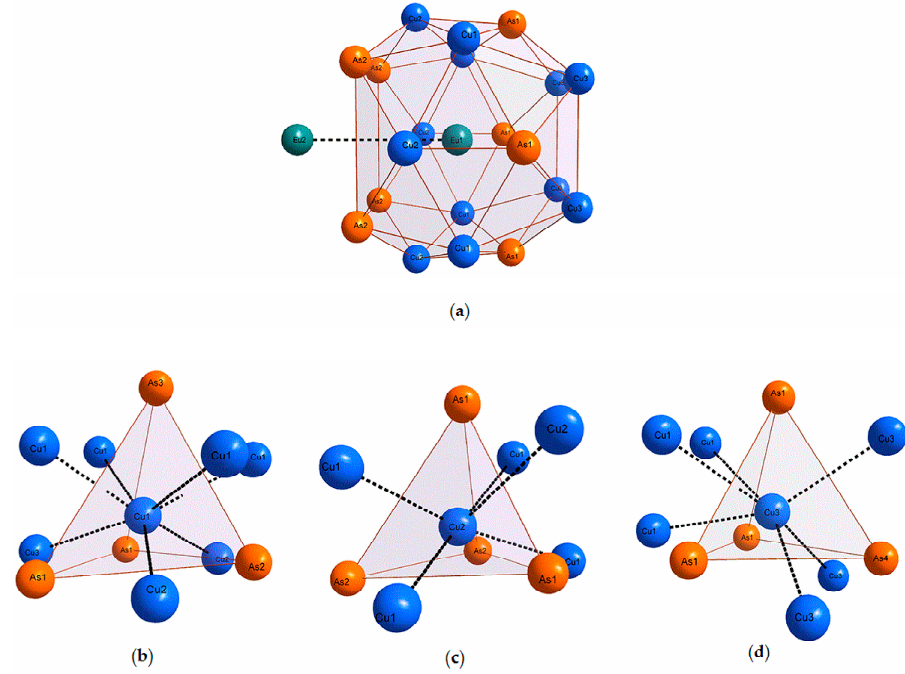
Figure 3. ( a – d ) Coordination polyhedra of Eu1, Cu1, Cu2, and Cu3, respectively, in the crystal structure of Eu 7 Cu 44 As 23 .